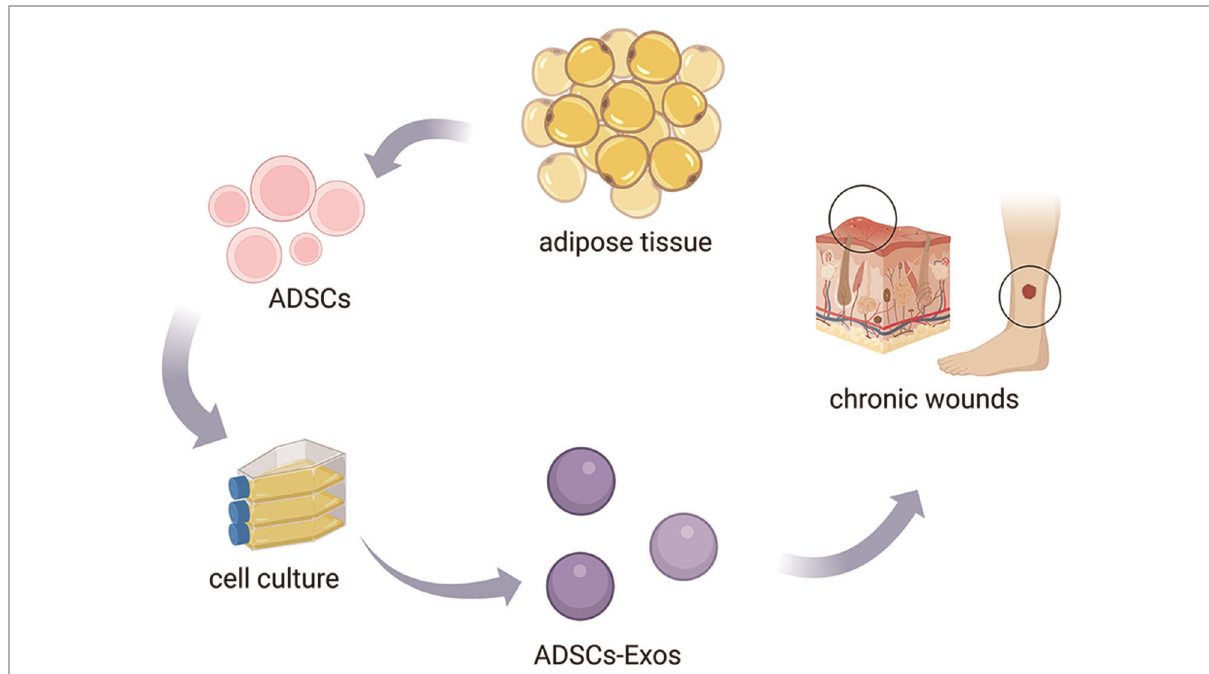
FIGURE 1 The production and applications of ADSCs-EXOs. Extracted from adipose tissue, ADSCs were collected and processed to obtain ADSCs-EXOs by cell culture. ADSCs-EXOs can apply to the treatment of chronic wound